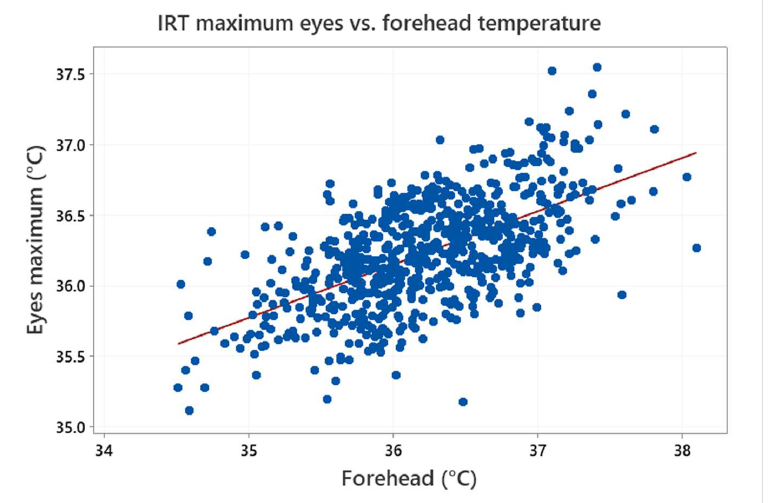
Figure 11. Relationship between the forehead and maximum eyes temperature measured by IRT (the symbols represent measured values and the line shows their linear regression). symbols represent measured values and the line shows their linear